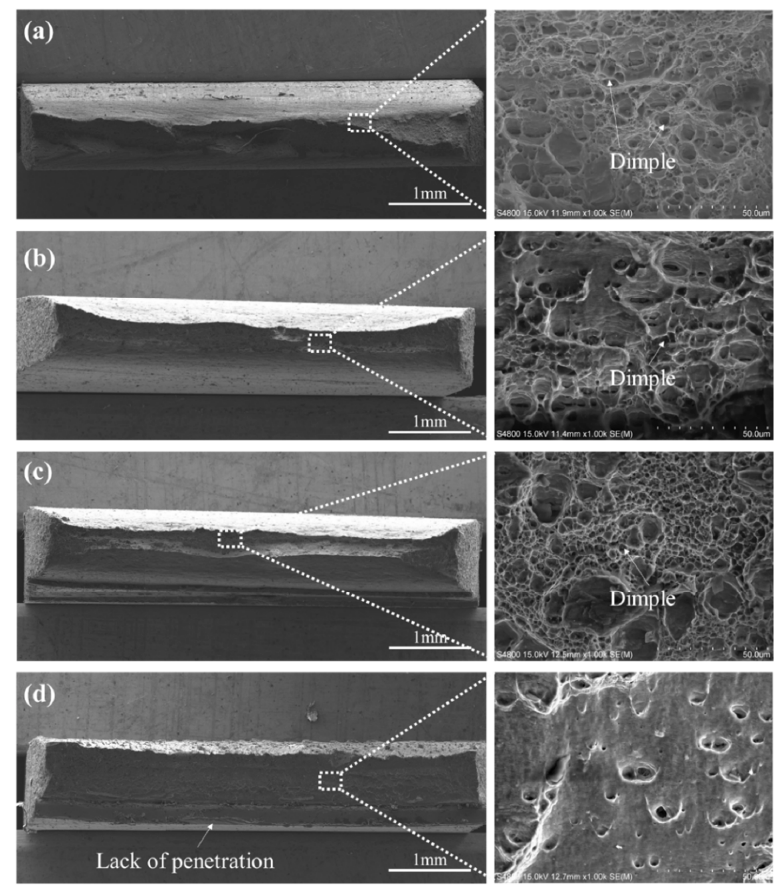
Figure 9. Fracture morphologies of the ( a ) AA5052-H32 base metal and μ -FSW joints obtained using ( b ) cordierite, ( c) Ti, and ( d ) Cu BPs.